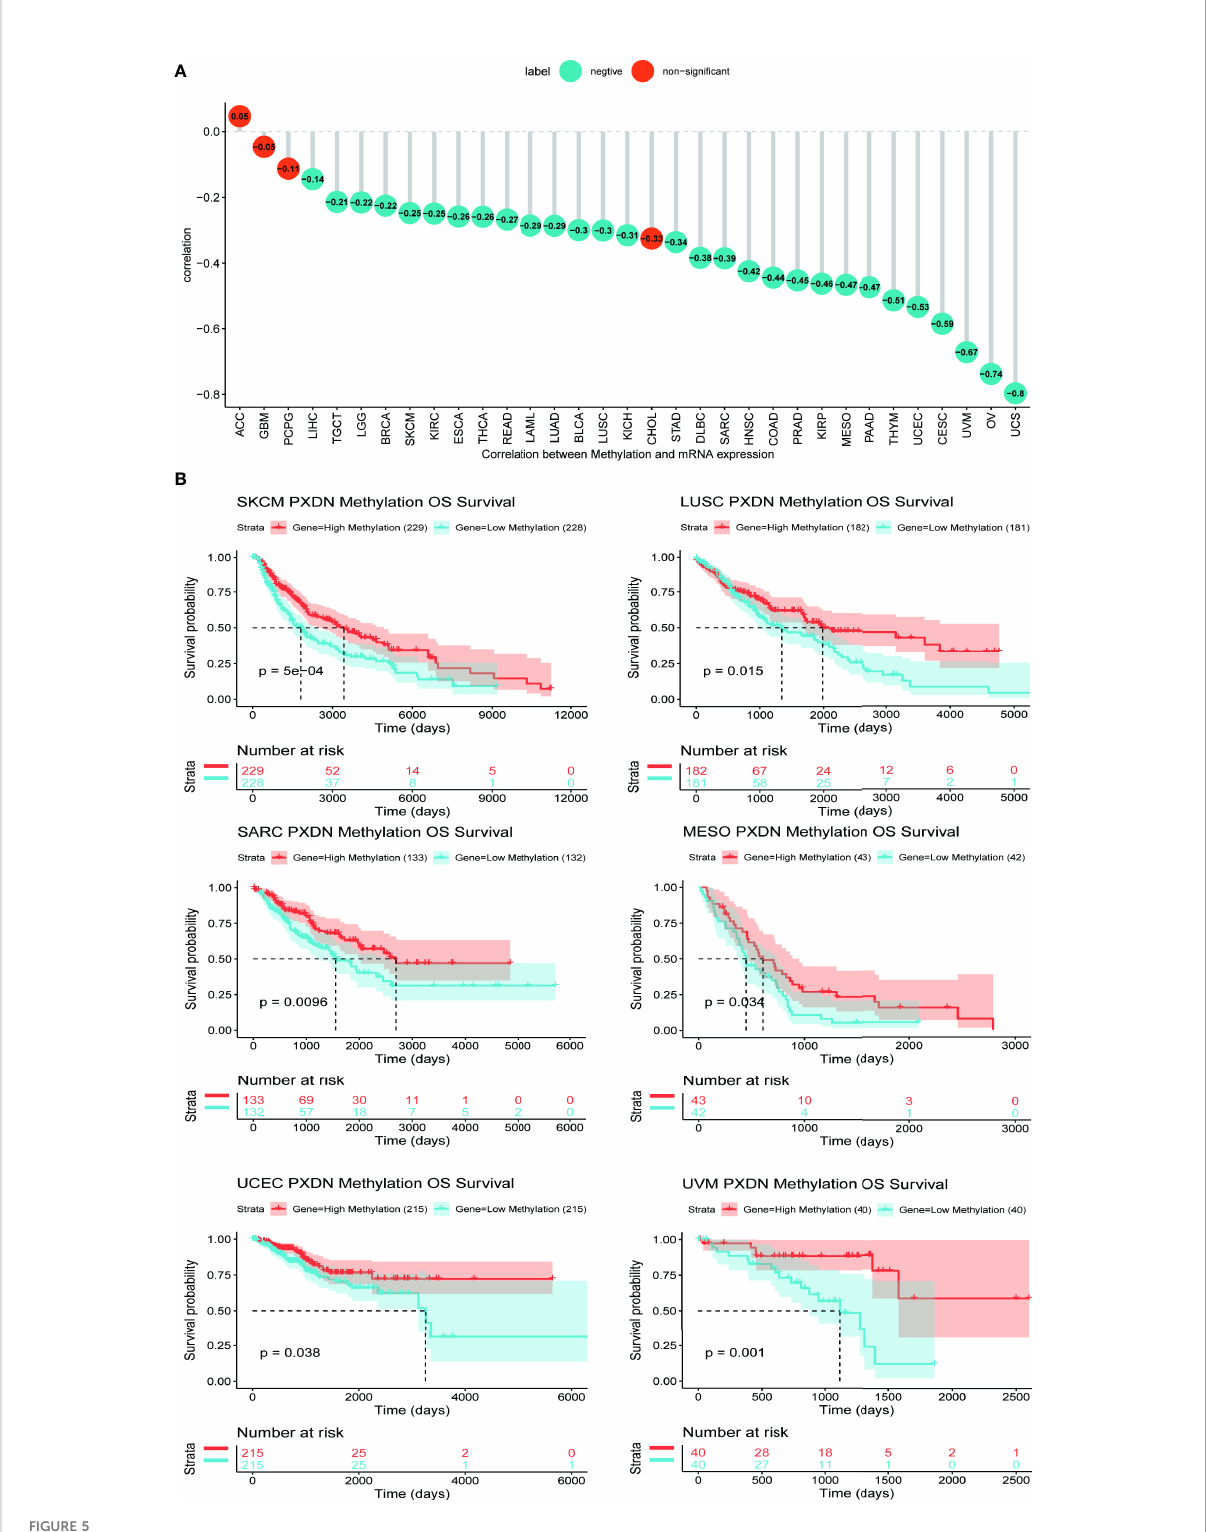
FIGURE 5 Relationship between PXDN expression and promoter methylation in different tumours. The results are based on data collated from cBioPortal database. (A) Relationship between PXDN expression and promoter methylation in 33 tumour types. (B) Kaplan-Meier survival analysis of the relationship between PXDN promoter methylation level and OS in SKCM, LUSC, SARC, MESO, UCEC,